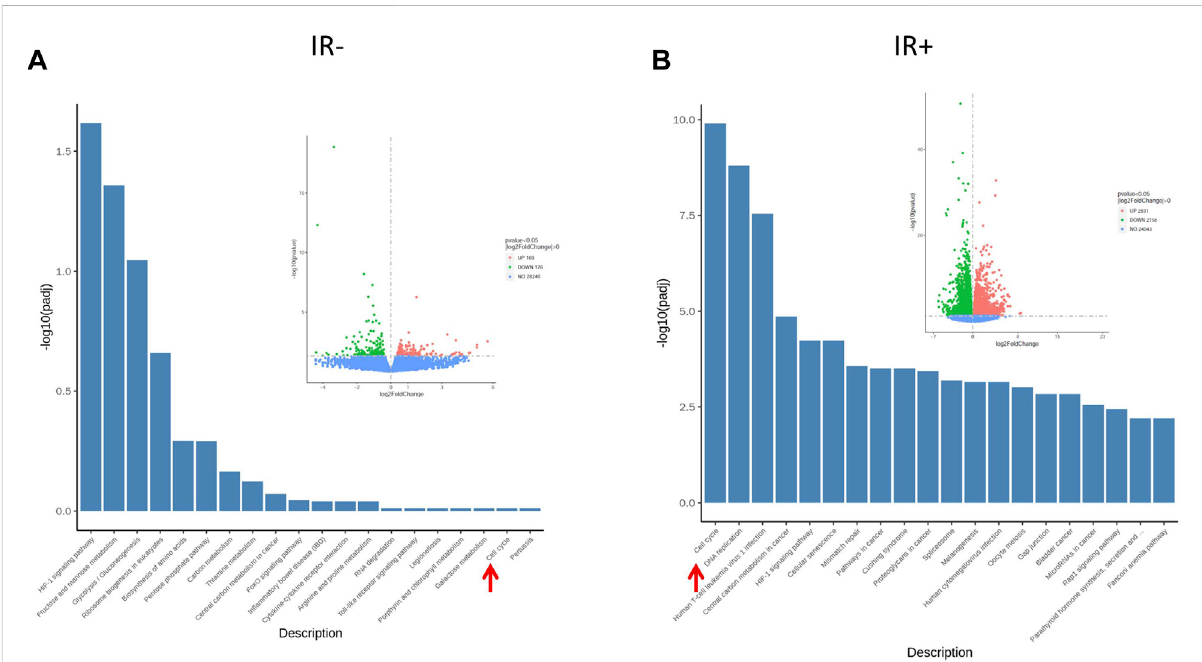
FIGURE 4 Irradiation (IR) promoted cell cycle regulator expression in radiation-resistant tissue. RNA-seq analysis of nonimplanted KS tissue compared with unirradiated tissue at 4 weeks after implantation (A) and irradiated tissue at 4 weeks after irradiation (B) . The insert from the volcano map indicatesthenumberofgenealterations.ThecolumnsareKEGGpathways,andthespotsarethenumberofgenes.Greenindicatesdownregulation, and red indicates upregulation. The red arrow indicates the cell cycle pathway. Shown are the mRNA levels (mean ± SD; n = 6) of the CKIs p21/ p53/p16 (C – E) and the promoter Cyclin D1 (F) . Data from three experiments with essentially the same results were combined and are presented as the mean ± SD; n = 6; *, p < 0.05; ***, p < 0.005; ****, p <